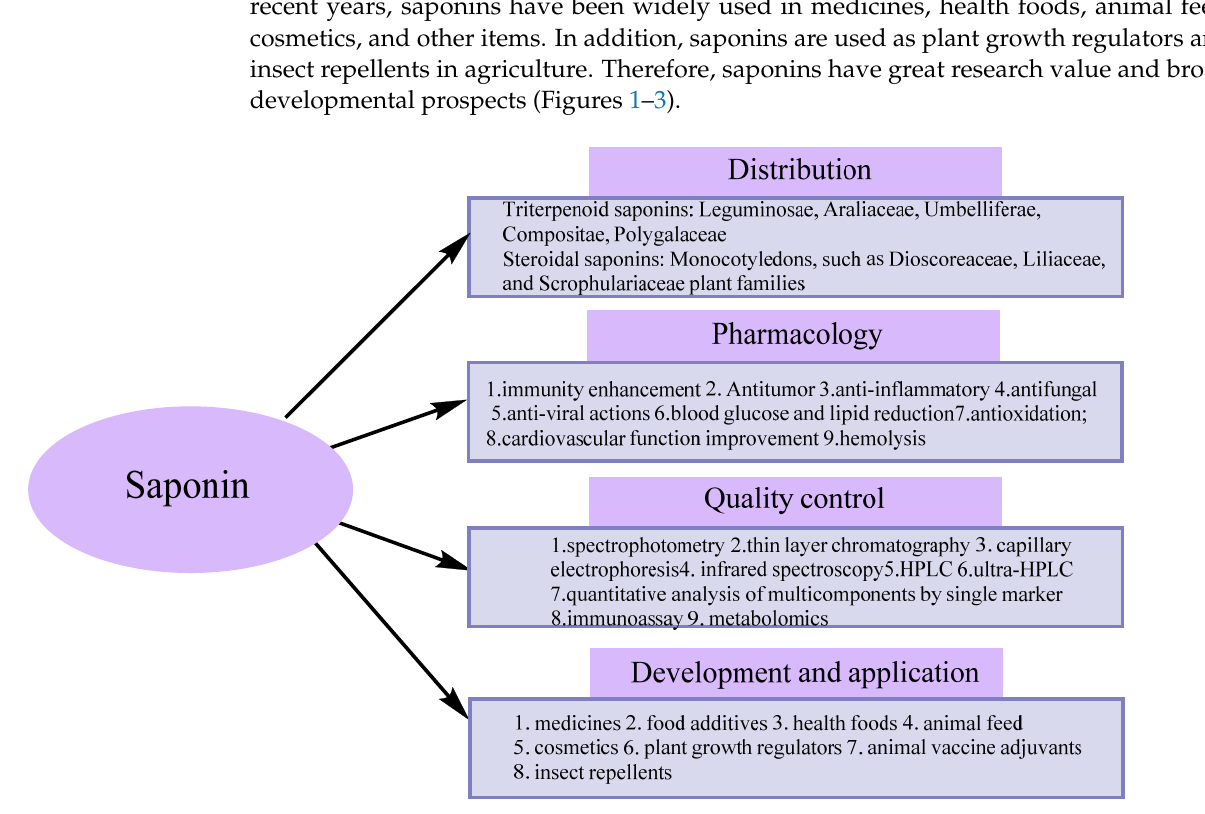
Figure 1. Saponins: distribution, pharmacology, quality control, development and application [5–17].